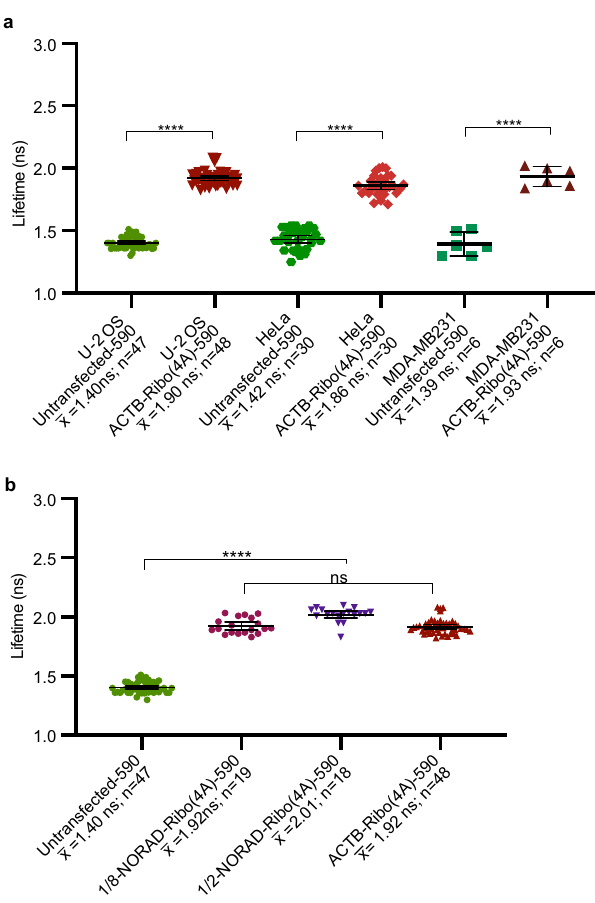
Fig. 4 | Assessing Riboglow-FLIM in different cell lines and fused to variable RNAs. Quantitative visualization of RNA sensing by fl uorescence lifetime imaging microscopy (FLIM) for different live mammalian cell lines ( a ) and different RNAs taggedwithRiboglow( b ).Average fl uorescencelifetimevalues(asde fi nedinFig.2) for live cells (204 cells, 4 independent experiments) transfected with listed plas- mids, identi fi ed via a transfection marker, loaded with Cbl-4xGly-ATTO590, and data processed as outlined in the work fl ow in Fig. 2a. One symbol = 1 cell, p -values listed(ns: p ≤ 0.5;* p ≤ 0.05;** p ≤ 0.01;*** p ≤ 0.001;**** p ≤ 0.0001).One-wayANOVA (95% con fi dence limit); post hoc test (Tukey HSD). Error bars indicate mean and standard deviation (+/ −